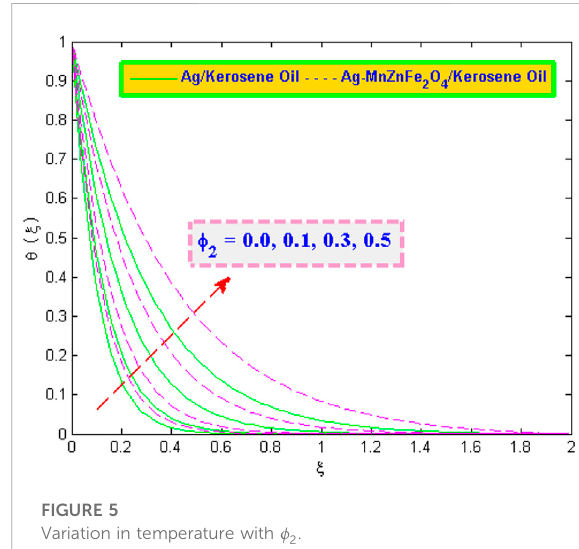
FIGURE 5 Variation in temperature with ϕ 2 .